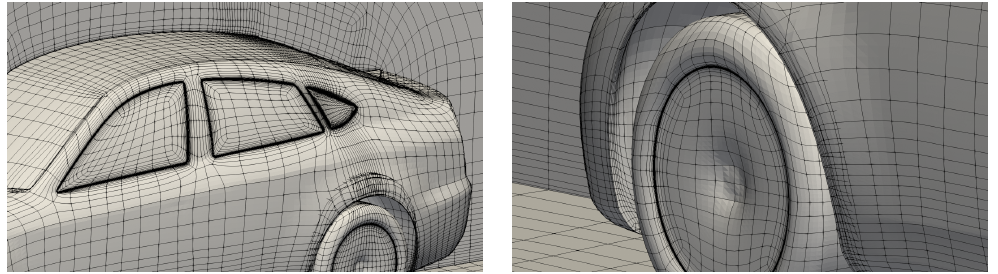
Figure 5. DrivAer model—Detail of the mesh near the rear end of the body ( left ) and the front wheel ( right